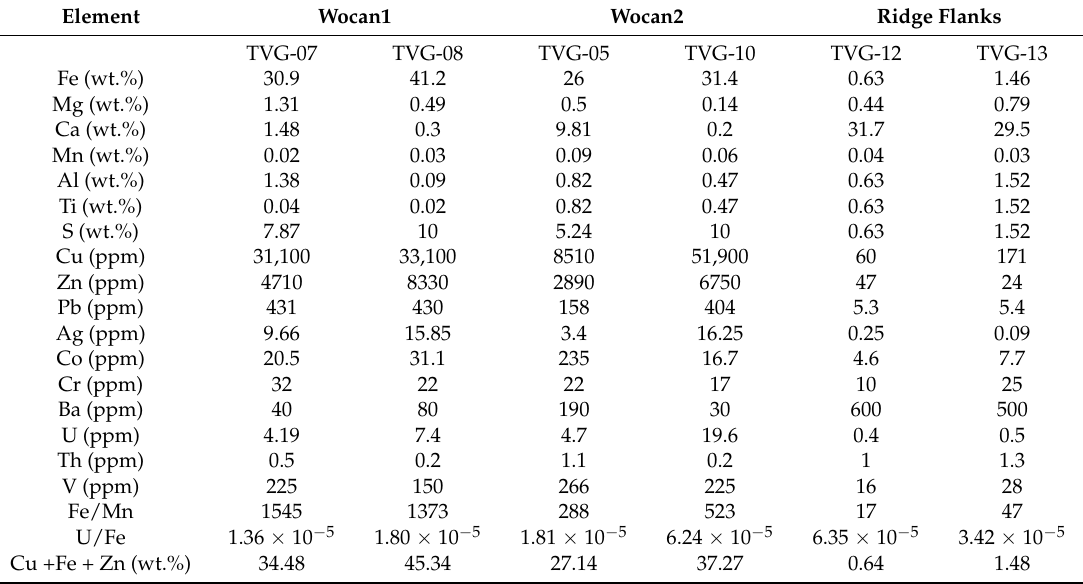
Table 3. Major and trace element compositions of the bulk sediment